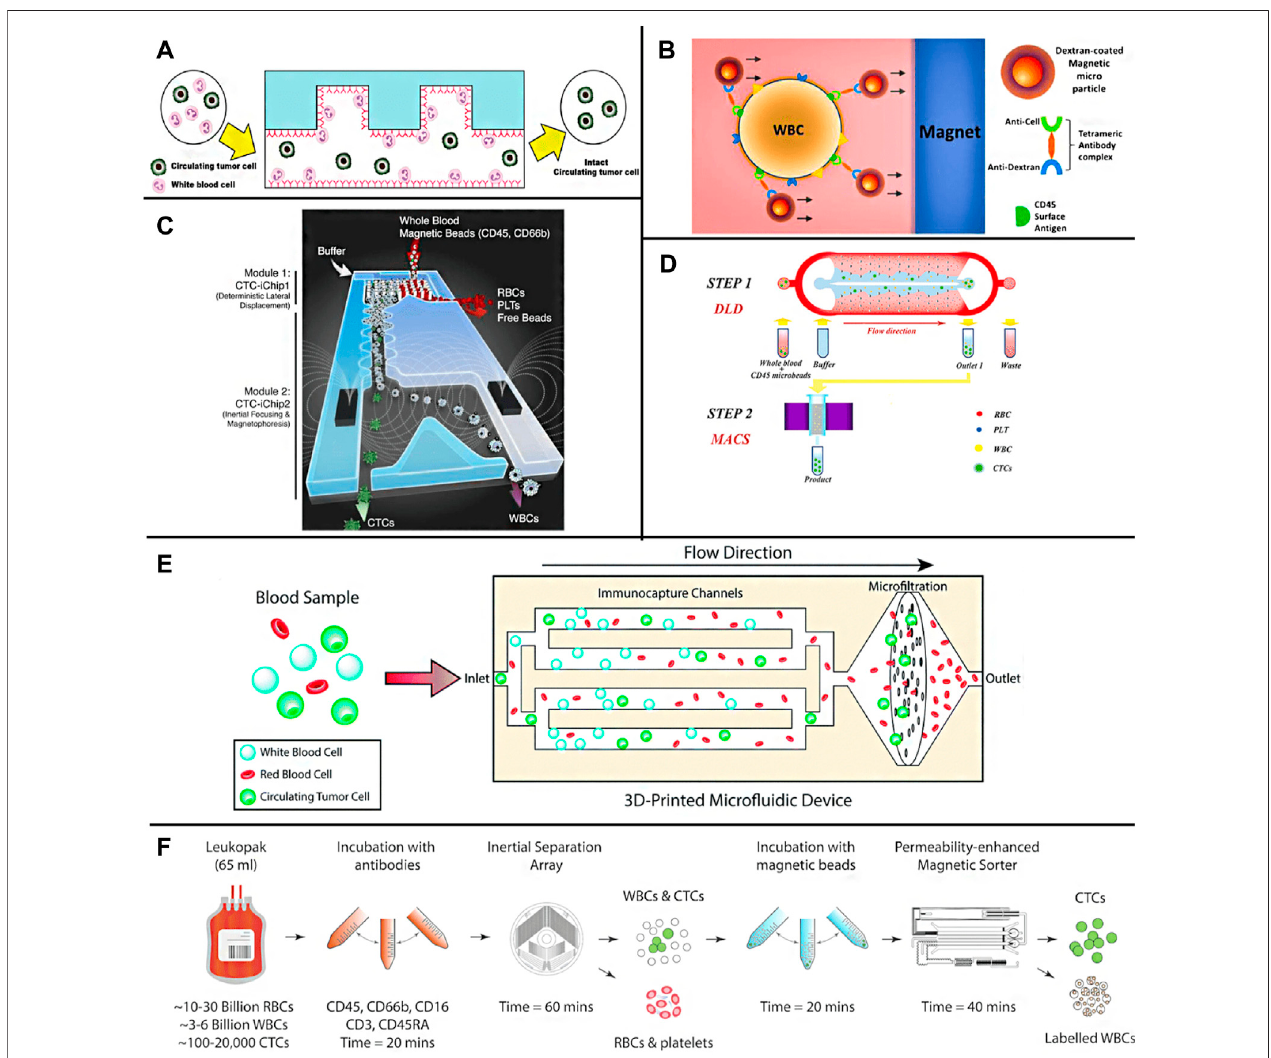
FIGURE 6 | Negative enrichment methods for CTCs (A) Pictorial presentation of negative enrichment of the GASI chip (Hyun et al., 2013); (B) Illustration of immunomagnetic WBC depletion in which magnetic particles bound to WBC through Tetrameric antibody complex in whole human blood (Sajay et al., 2014); (C) The CTC-iChipschematic(Karabacak etal.,2014); (D) ThecaptureplatformintegratingaDLDstructure withaMACSseparatorforinlineoperation(Wanget al.,2019); (E) A schematicshowingthetumorcellenrichmentprocessinthe3D-printedmicro fl uidicdevice(Chuetal.,2019); (F) Aschematicsillustratingthemicro fl uidicapproach for untouched CTCs isolation from leukapheresis products (Mishra et al.,